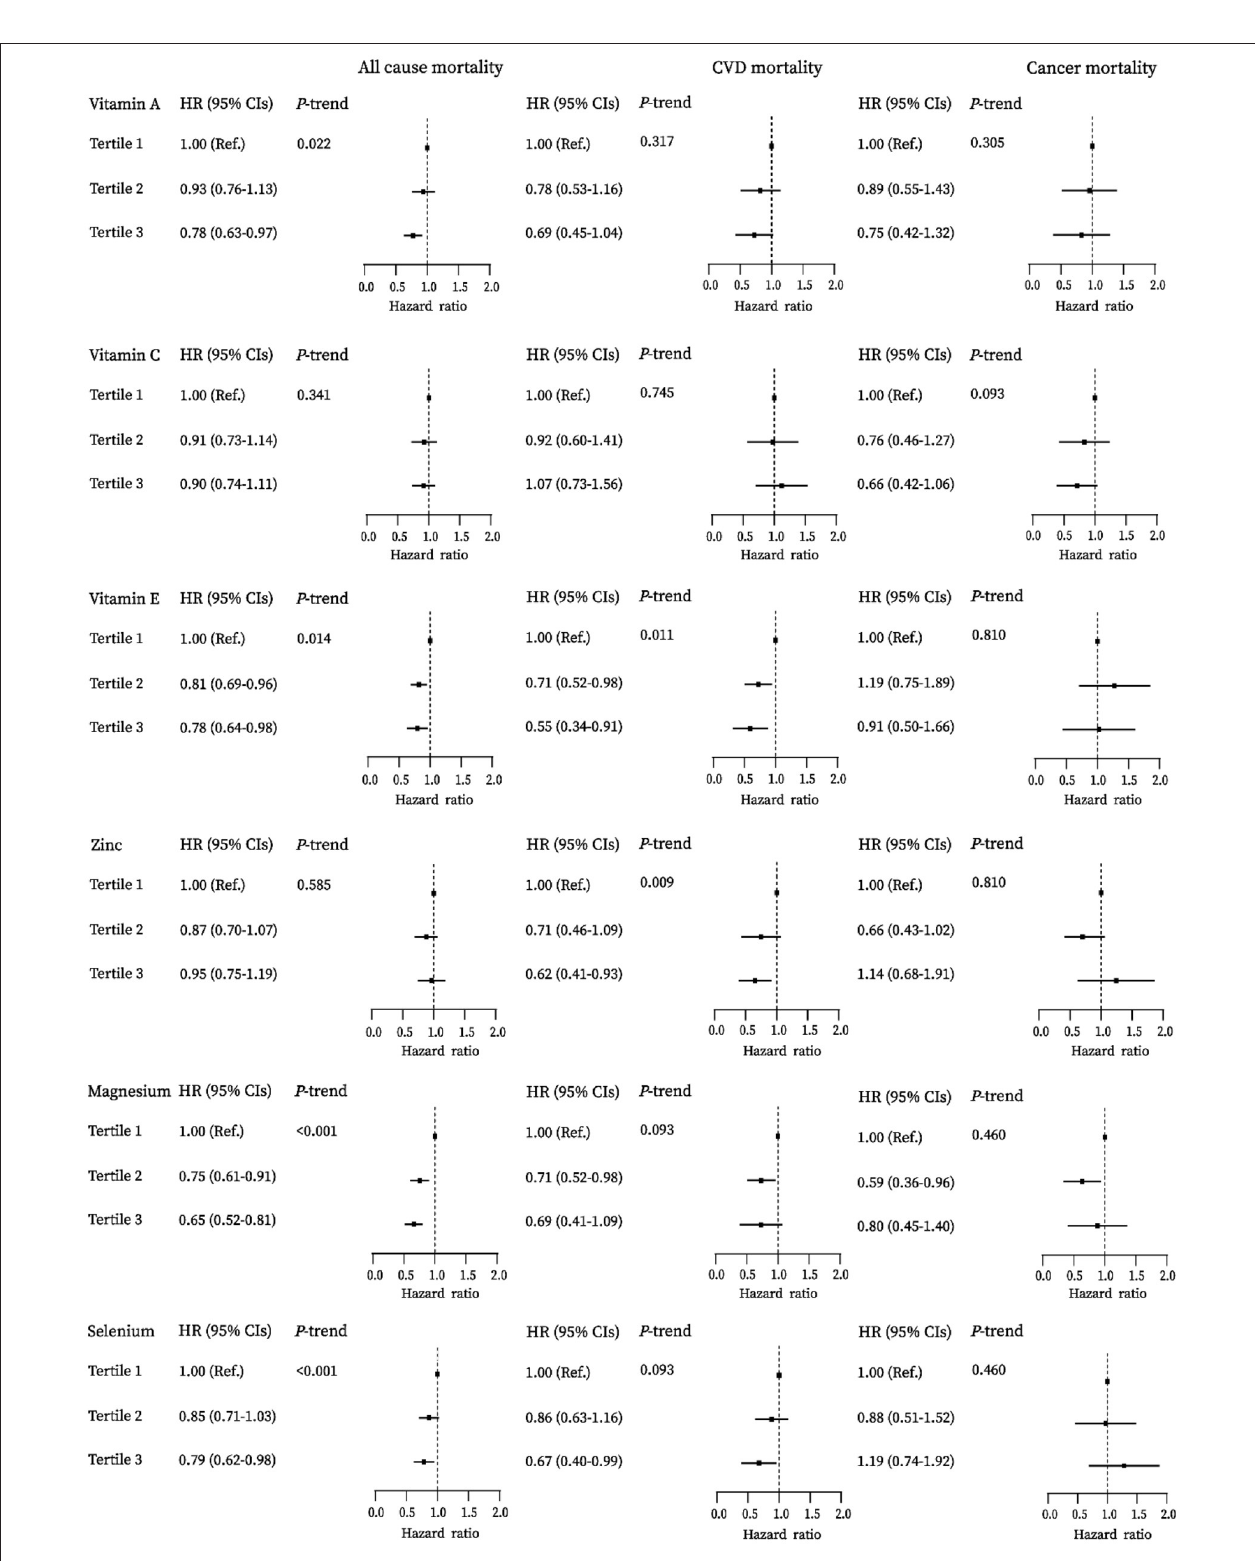
FIGURE 1 | Associations between vitamins A, C, E, zinc, magnesium, and selenium with all-cause, cardiovascular disease (CVD), and cancer mortality among diabetes in the National Health and Nutrition Examination Survey (NHANES) (2003–2014).